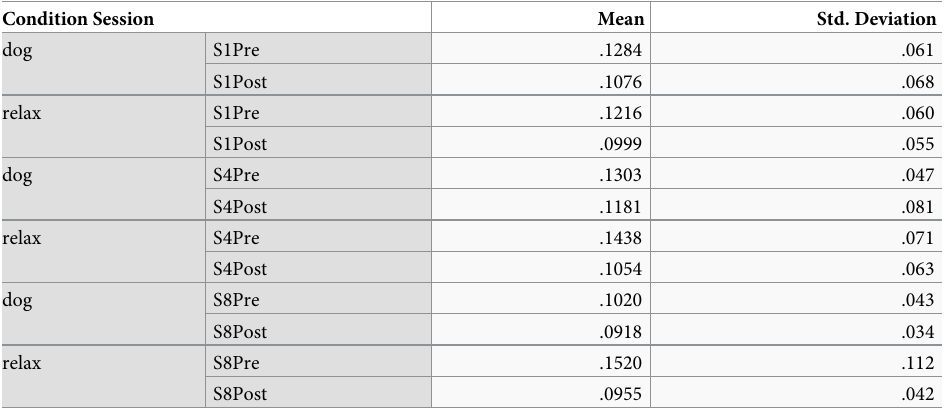
Table 2. Overview table: Acute cortisol, mainstream